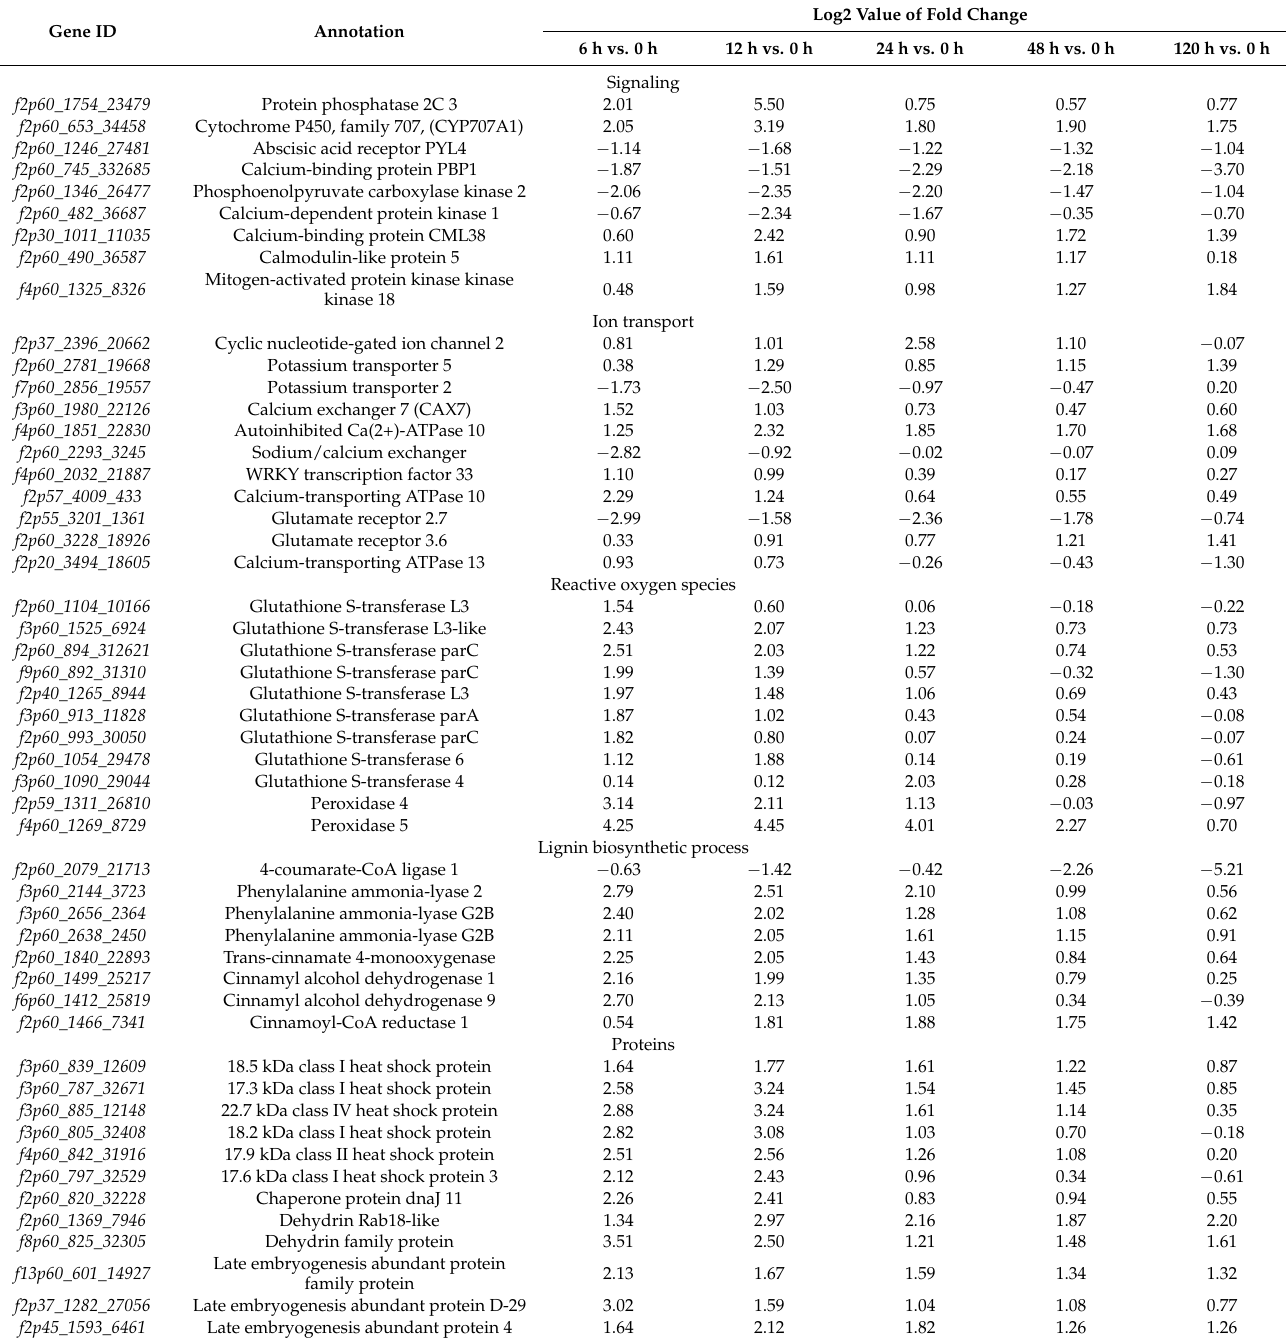
Table 2. List (sections) of differentially expressed genes in